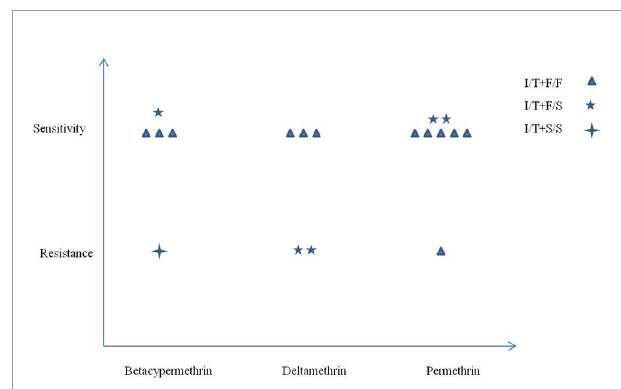
FIGURE 3 | Correlation between mutations at codons 1532 and 1534 and pyrethroid resistance in Ae. albopictus populations from Zhejiang Province, central